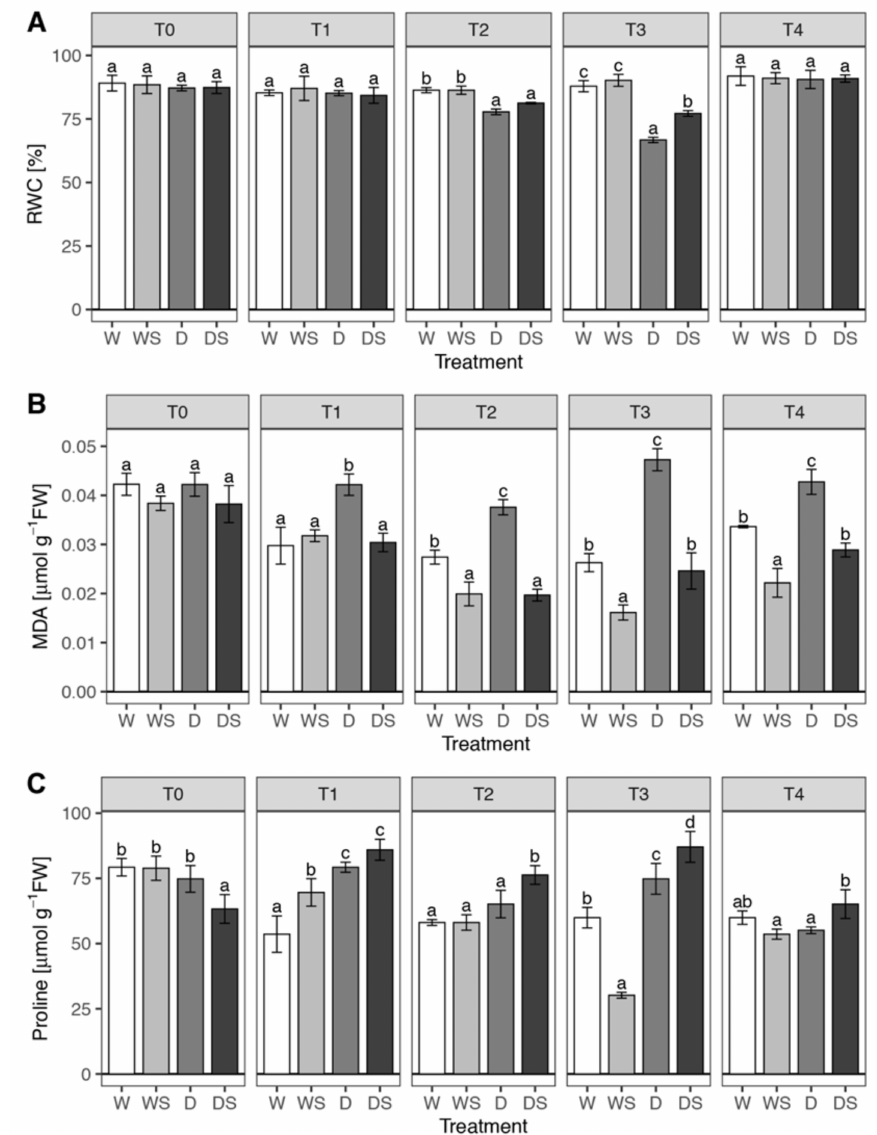
Figure 4. Changes in relative water content (RWC) ( A ), malondialdehyde (MDA) ( B ), and Proline ( C ) in Impatiens plants under drought stress and in response to SA. Watered plants (W); drought-stressed plants (D); watered plants treated with SA (WS); drought-stressed plants treated with SA (DS). T0–T4 are di ff erent sampling points (see Figure 1). Each bar represents the average RWC, MDA or proline of three biological replicates. Variation between biological replicates is indicated by error bars representing standard deviation. The data was analyzed using factorial analysis of variance (ANOVA, Tables S5, S6 and S7). The e ff ect of the three-way interaction dehydration:SA:time was significant on each dependent variable, so pairwise comparisons of estimated marginal means were conducted within each sampling time (T0–T4) using Tukey’s method and significant di ff erences ( p < 0.05) are indicated by a compact letter displayed above the